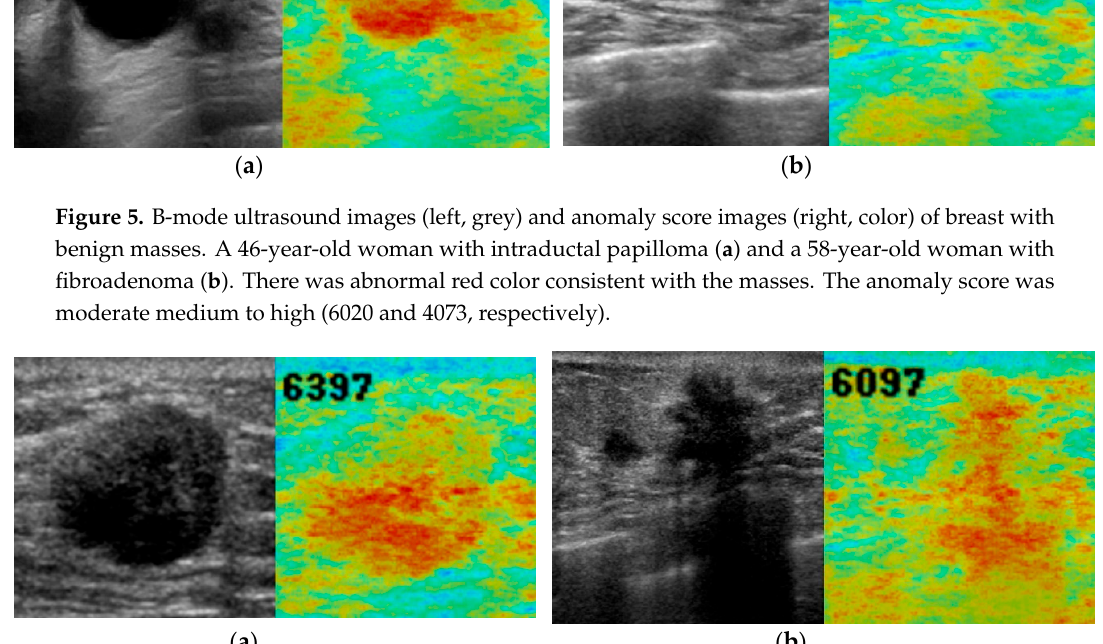
Figure 6. B-mode ultrasound images (left, grey) and anomaly score images (right, color) of breast with malignant masses. A 71-year-old woman with invasive ductal carcinoma ( a ) and a 71-year-old woman with invasive lobular carcinoma ( b ). Abnormal red color was observed on and around the masses. The anomaly score was high (6397 and 6079, respectively).